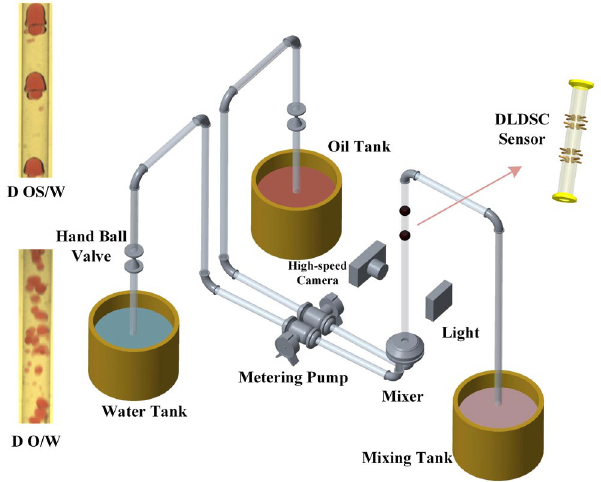
Figure 1. Schematic of vertical upward oil-water two-phase flow loop